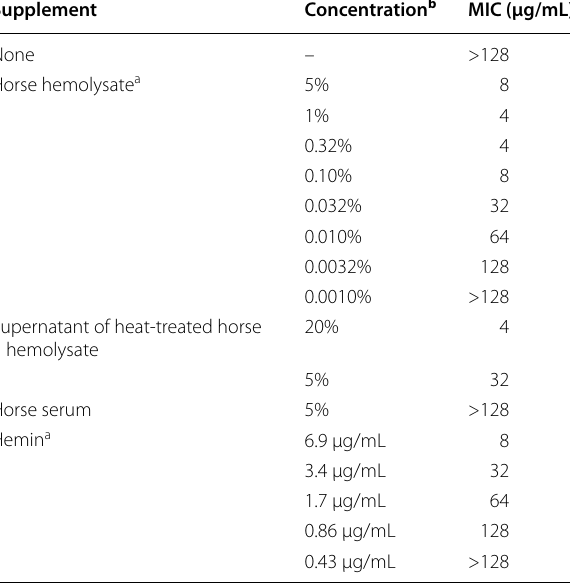
Table 4 The effect of medium supplemented with horse hemolysate, hose serum, and hemin on the MIC of the Natto peptide with S. pneumoniae R6